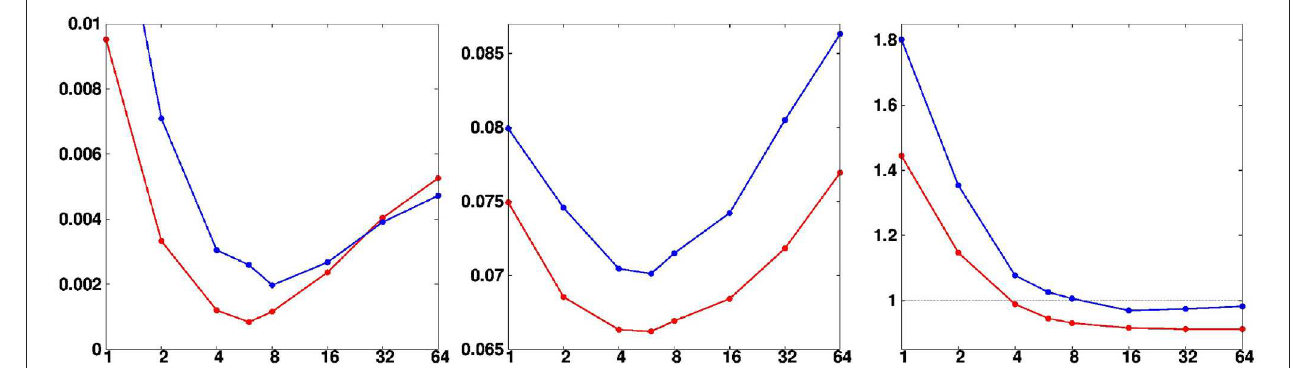
FIGURE 10 | Final reliability (Left) , resolution (Middle) , and optimality (Right) scores as a function of localization degree l 1 . The red line corresponds to the nominal ensemble size ( m 100, used in all figures above), and the blue line, to a smaller ensemble size ( m =